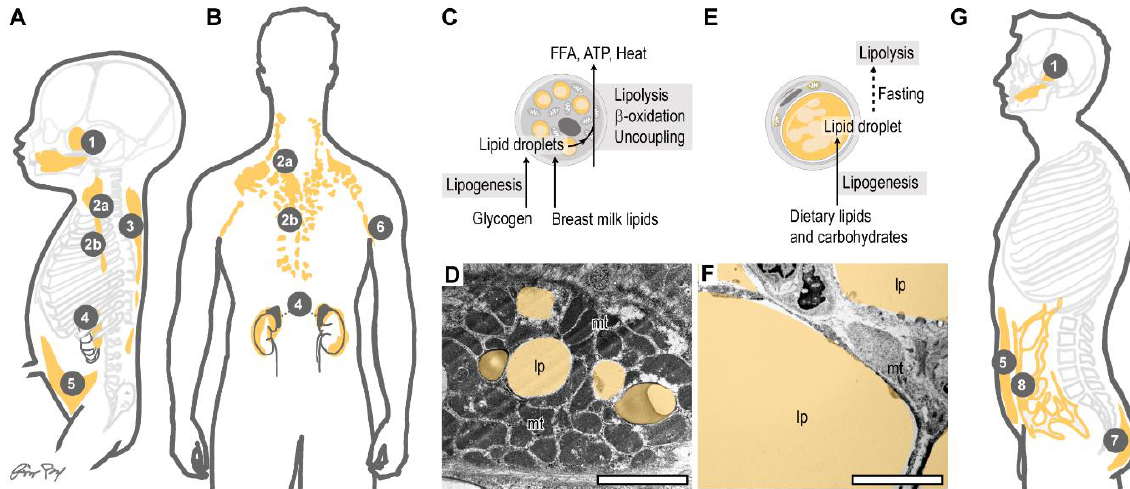
Figure 2. Thermogenic and fat storing adipose tissue depots. ( A ) Thermogenic fat depots of a human term infant. ( B ) Thermogenic fat depots of a human adult. 1: buccal fat pad, 2a: supraclavicular fat depot, 2b: mediastinal fat depot, 3: interscapular and subcutaneous fat of the trunk, 4: fatty capsule of the kidney, 5: abdominal and inguinal subcutaneous fat depot, 6: axillary fat depot, 7: gluteal fat pad, 8: omental fat ( C ) Fat metabolism of the adipose tissue in a newborn.